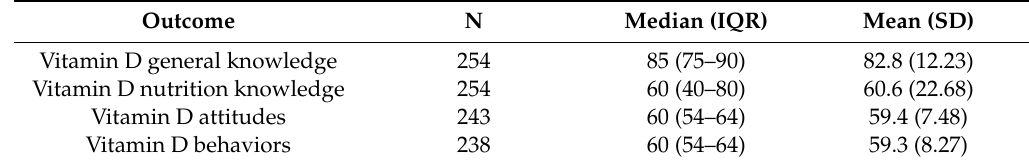
Table 2. Scores for vitamin D knowledge, attitudes, and